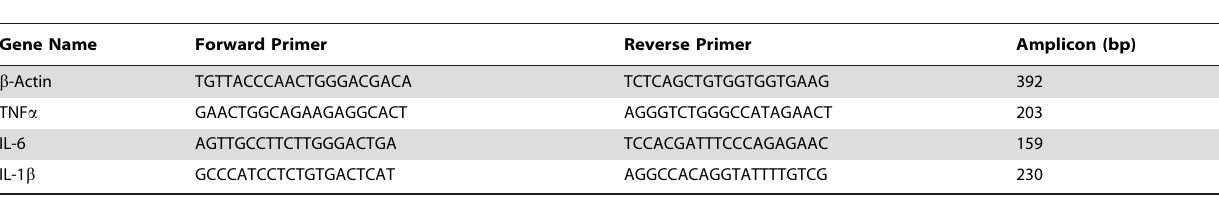
Table 2. Semi-qPCR primer sequences and expected amplicon size.